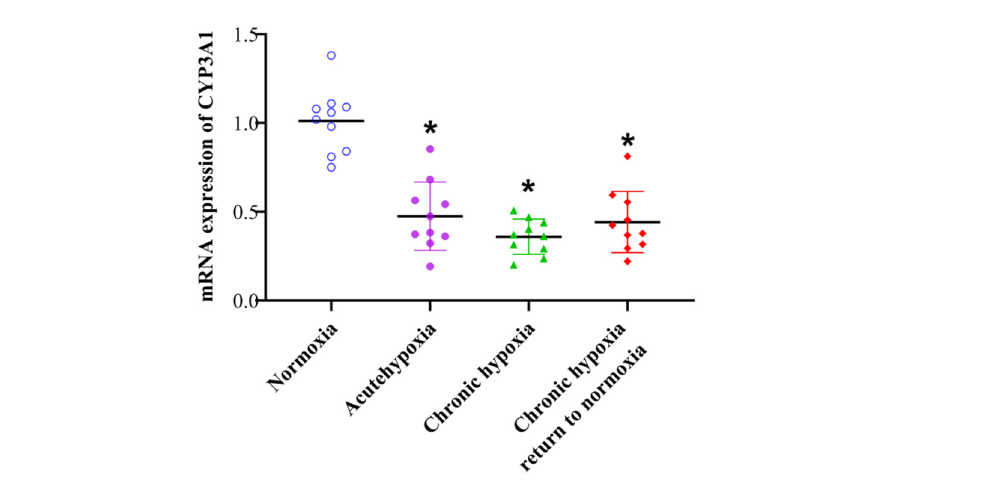
Figure 13. The mRNA expression of CYP3A1 in rats after exposure to high-altitude hypoxia. The data are presented as the mean ± SD. n = 10. * p < 0.05 compared to the normoxia group.